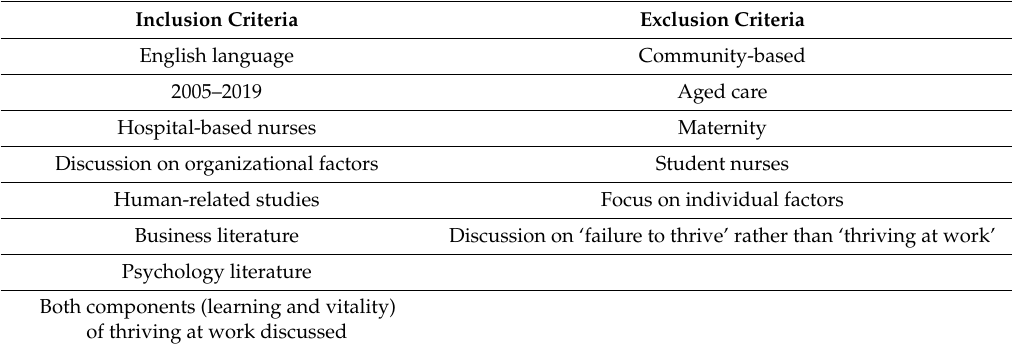
Table 1. Inclusion and exclusion